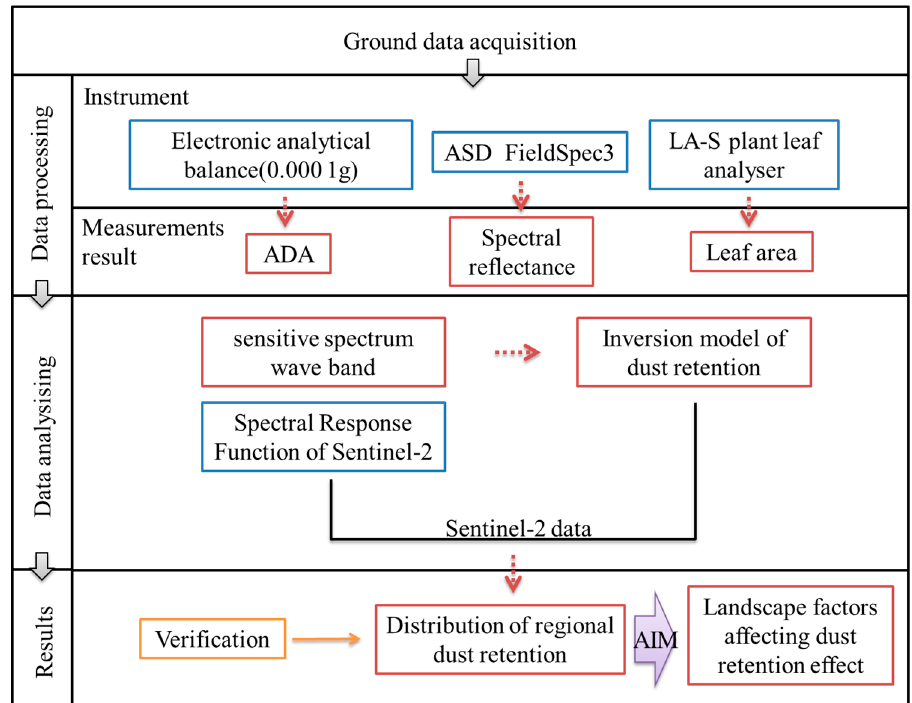
Figure 2. The main processes of this study.